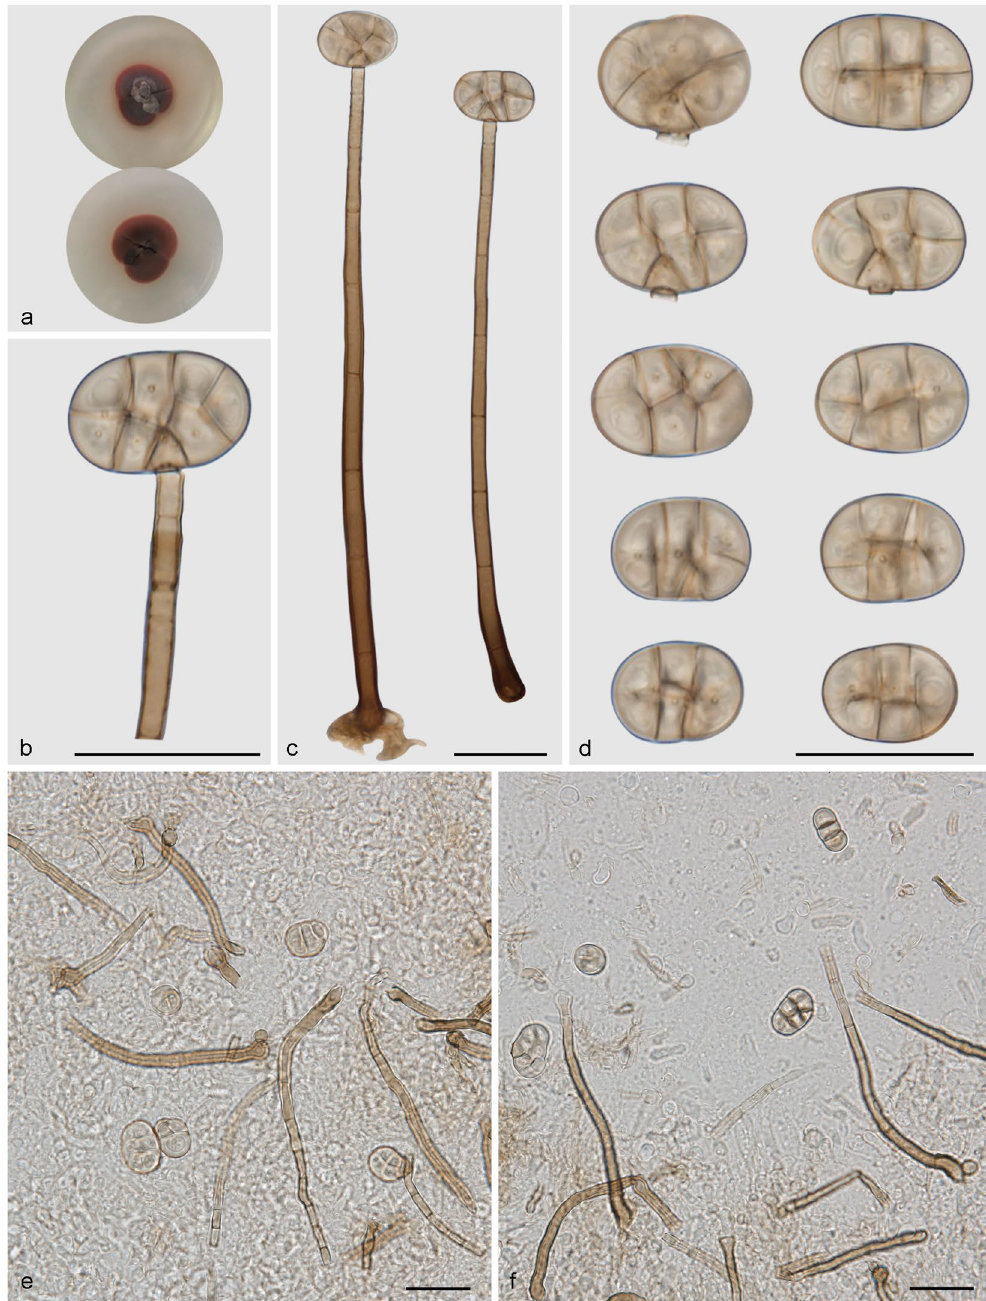
Figure 11. Junewangia queenslandica. ( a ) Colony on PDA (surface and reverse). ( b – d ) From natural substrate (HSAUP H7722): ( b ) Conidiogenous cells with conidia, ( c ) Conidiophores with conidia, ( d ) Conidia. ( e , f ) From PDA (CGMCC 3.18654): Conidiophores and conidia. — Scale bars = 20 μ